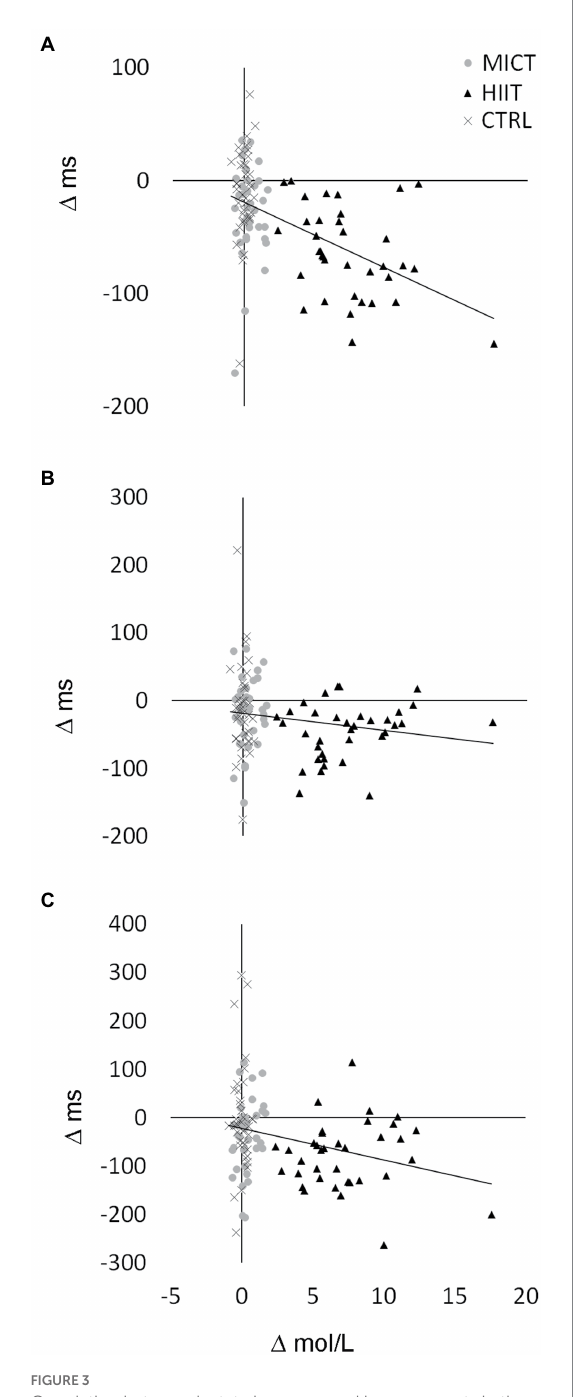
FIGURE 3 Correlation between lactate increases and improvements in the different conditions of the Stroop test. r and p of the correlations can be shown in text. (A) Congruent condition. (B) Neutral condition. (C) Incongruent